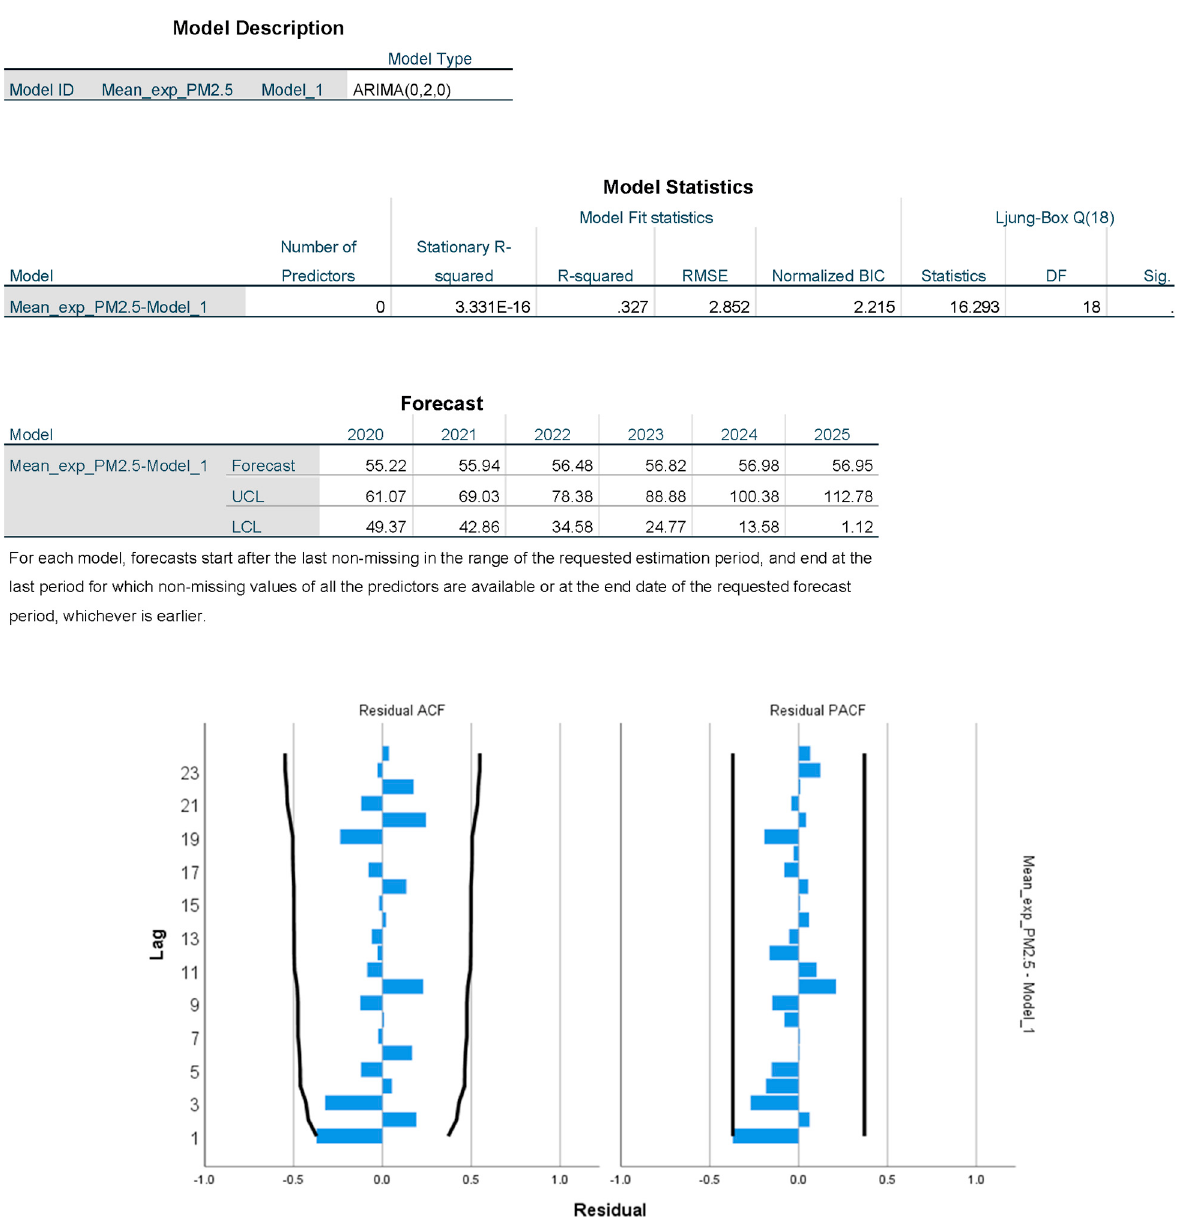
Figure A7. Model (3) Forecast in mean population exposure to PM 2.5 .